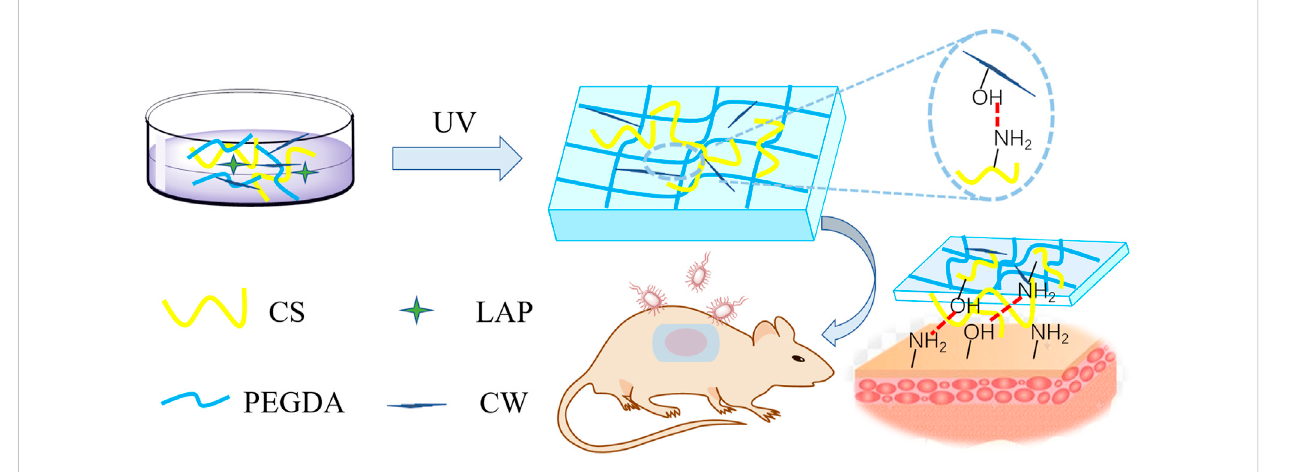
FIGURE 1 Structure scheme of the adhesive and elastic hydrogel for wound